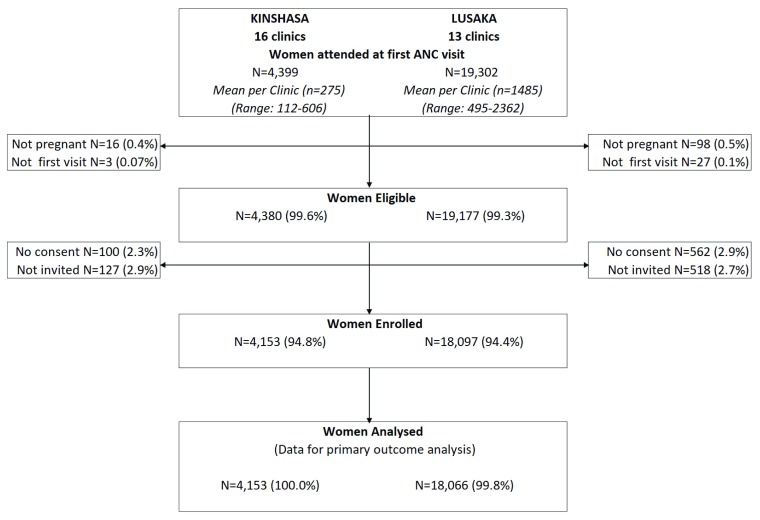
Study enrollment diagram.